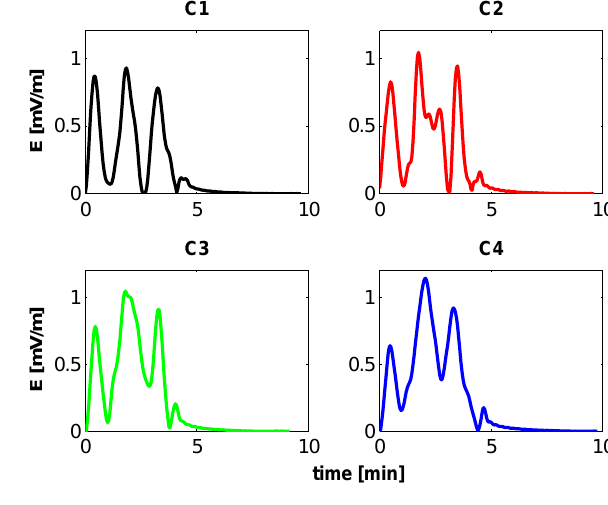
Fig. 4. Standard deviation as function of x for spacecraft C4. The minimum 13.7 R E corresponds to X-line location at 29.7 R E .